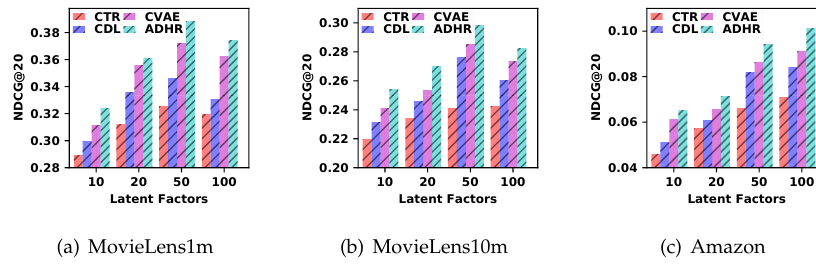
Figure 5. Cold-start recommendation performance w.r.t. latent